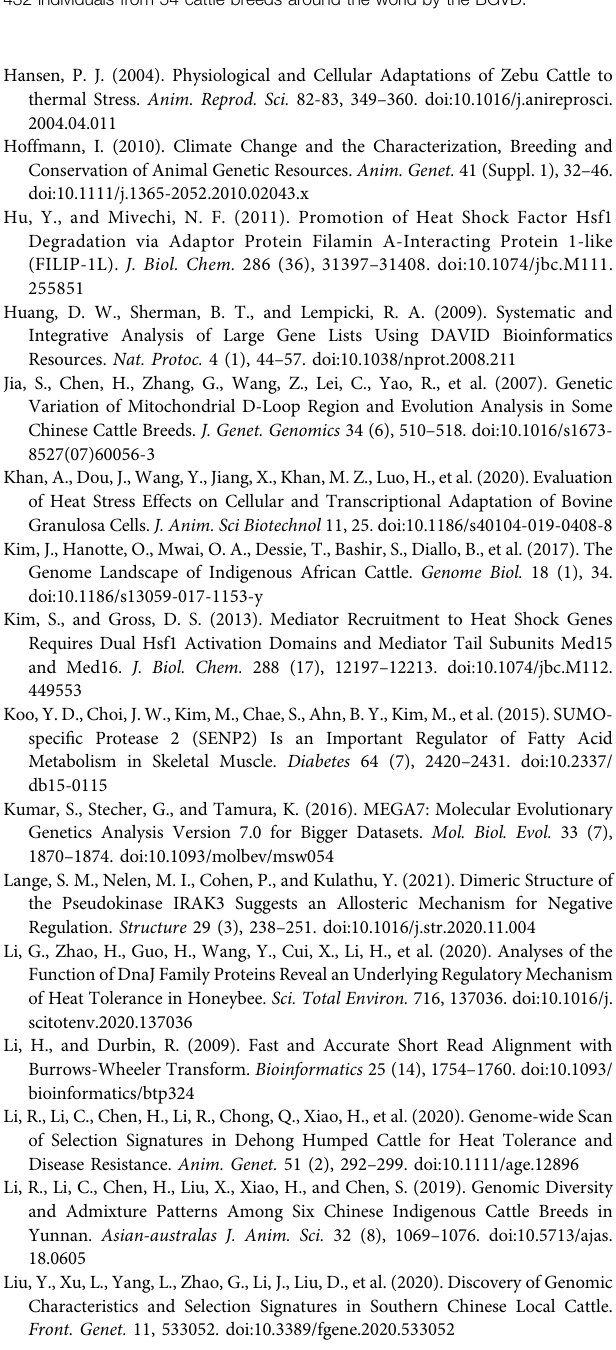
Supplementary Figure S1 | Information for each group. (A) Locations for each cattle population. (B) The speci fi c and shared SNPs for each group. The numbers in the circle components show speci fi c SNPs for each group or overlapping SNPs among groups. Supplementary Figure S2 | F ST , TajimaD, nucleotide diversity, or degree of haplotype sharing across populations. The major allele at each SNP position is colored in yellow. (A) MED16 gene region (B) IRAK3 gene region (C) SENP2 gene region (D) FILIP1L gene region (E) HSPA4 gene region (F) BCL2L1 gene region (G) TPX2 gene